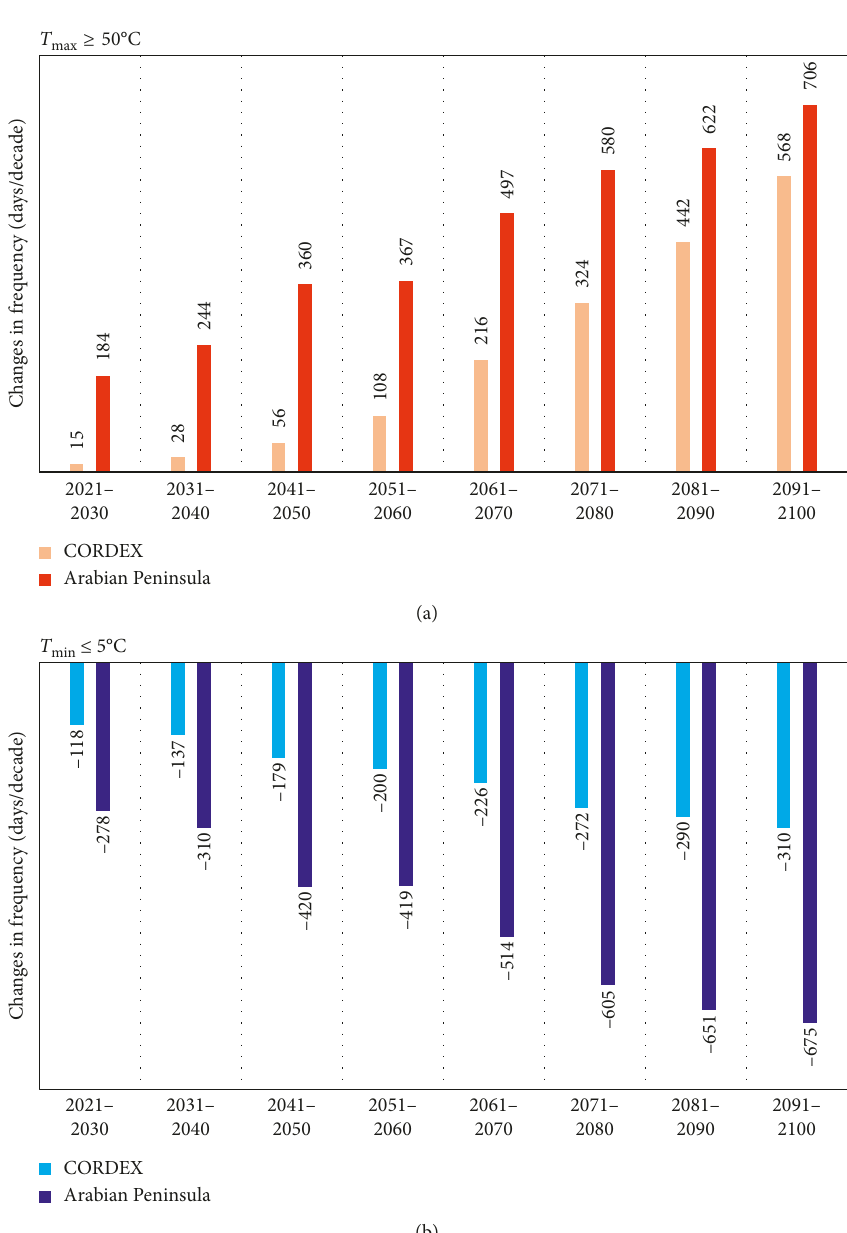
° C) and cold nights ( T ° C) with respect to the reference period max ≥ 50 min ≤ 5